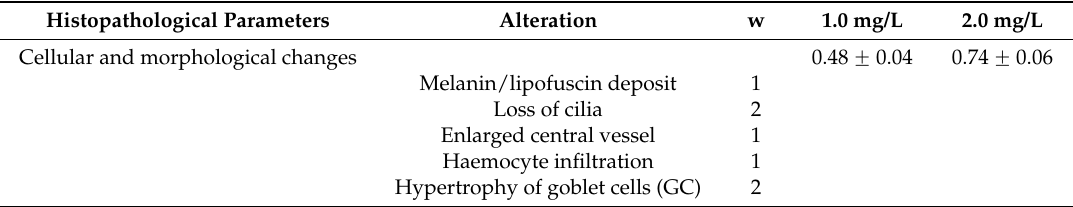
Table 1. Average gill histopathological condition indices ( ˘ 95% confidence intervals) for each tank and respective alteration